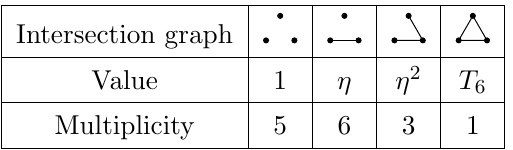
Table 2 . All the intersection graphs for the sixth